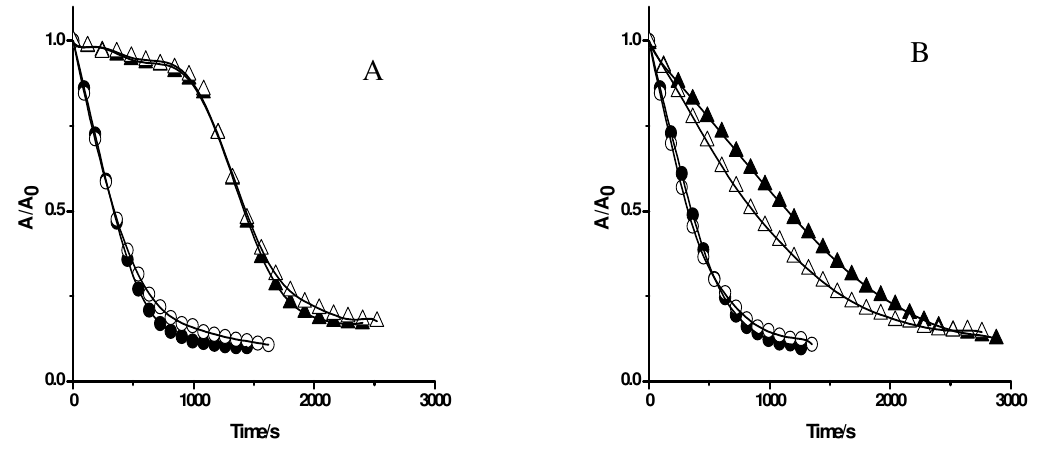
Figure 7. Effect of complex mixtures on the consumption of PGR (5 µM) induced by AAPH (10 mM) derived peroxyl radicals. A : orange juice (6.7 µL/mL) in the absence ( (cid:2) ) and presence of Triton X-100 micelles ( (cid:1) ). B : seed extract of Eugenia jambolana (10 µL/mL) in the absence ( (cid:2) ) and presence of Triton X-100 micelles ( (cid:1) ). Control experiments (without additives) were measured in the absence ( (cid:1) ) and presence ( (cid:1) ) of Triton X-100 micelles.